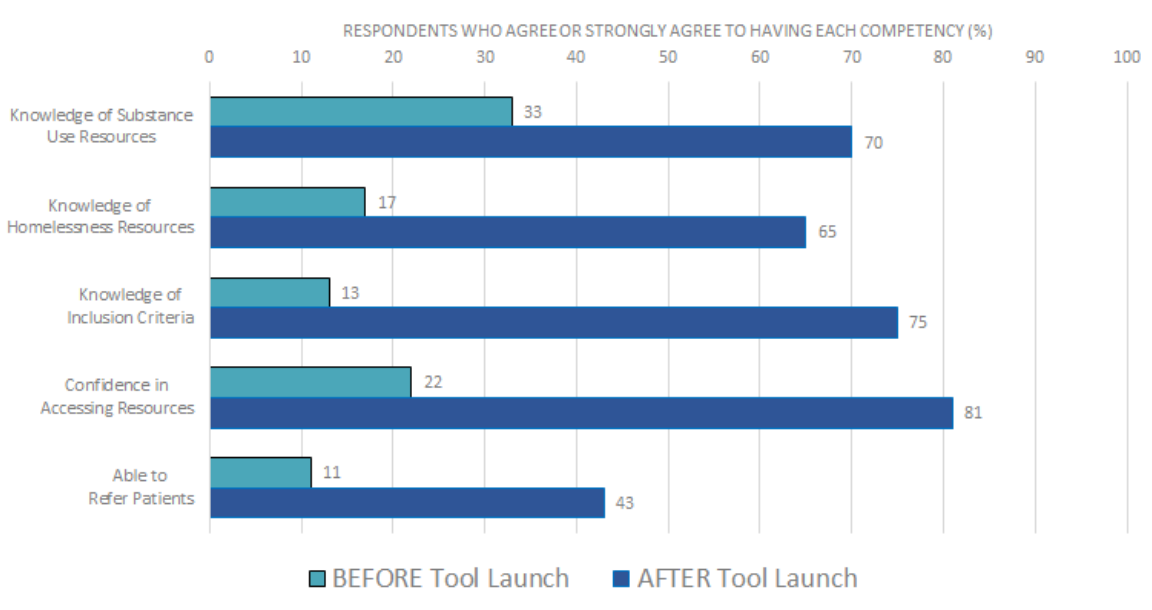
Figure 5. Clinician perceptions of the digital decision tool’s usability and